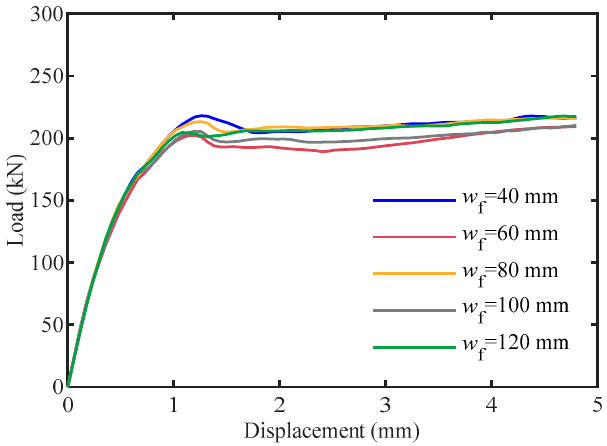
Figure 18. Influence of the flange width of the T-stub connector.